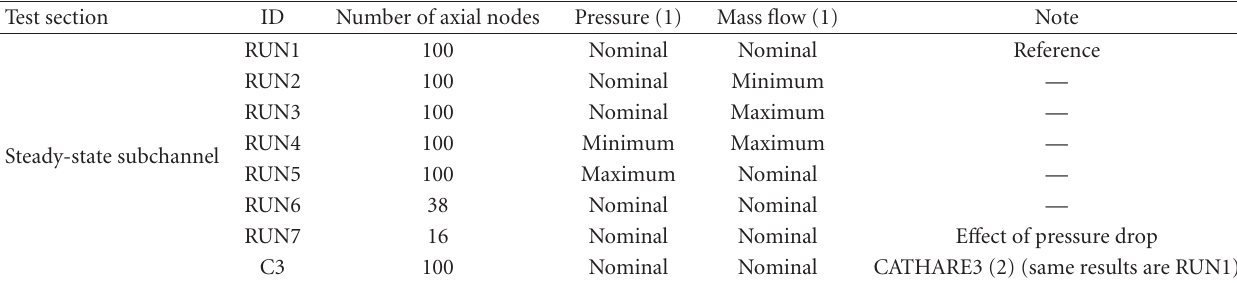
Table 3: PSBT subchannel tests: list of reference and sensitivity calculations.